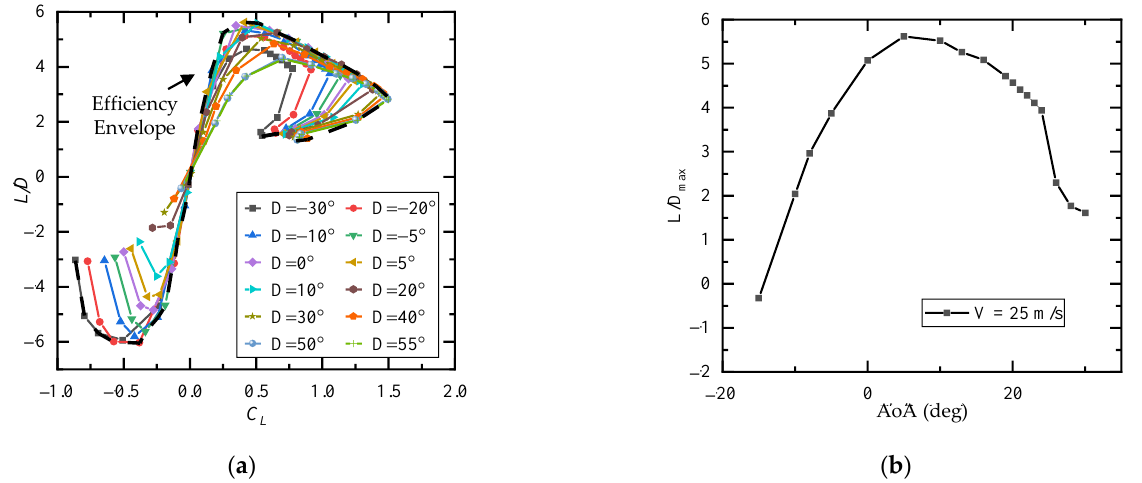
Figure 21. Efficiency envelope for mTE4 (airspeed 25 m/s). ( a ) Maximum lift-to-drag ratio for different lift coefficients and actuation inputs. ( b ) Maximum lift-to-drag ratio for different angles of attack.